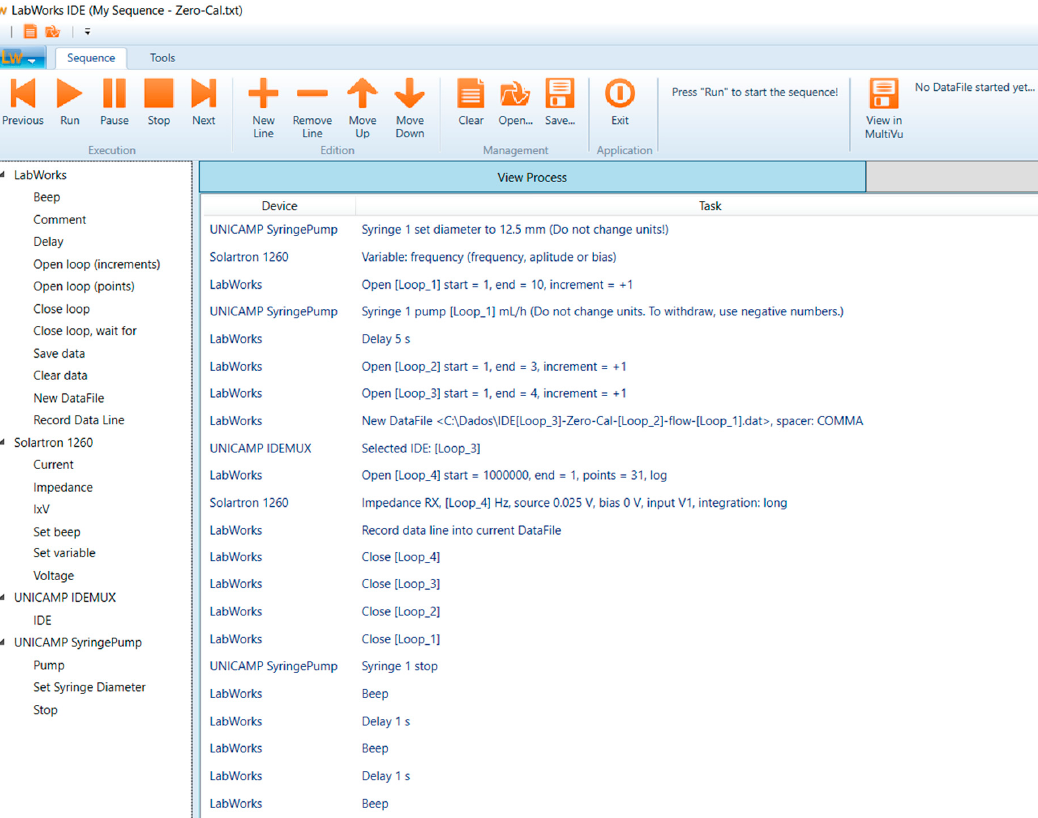
Figure 3. Software used for controlling the three instruments: custom-made syringe pump, Solartron Figure